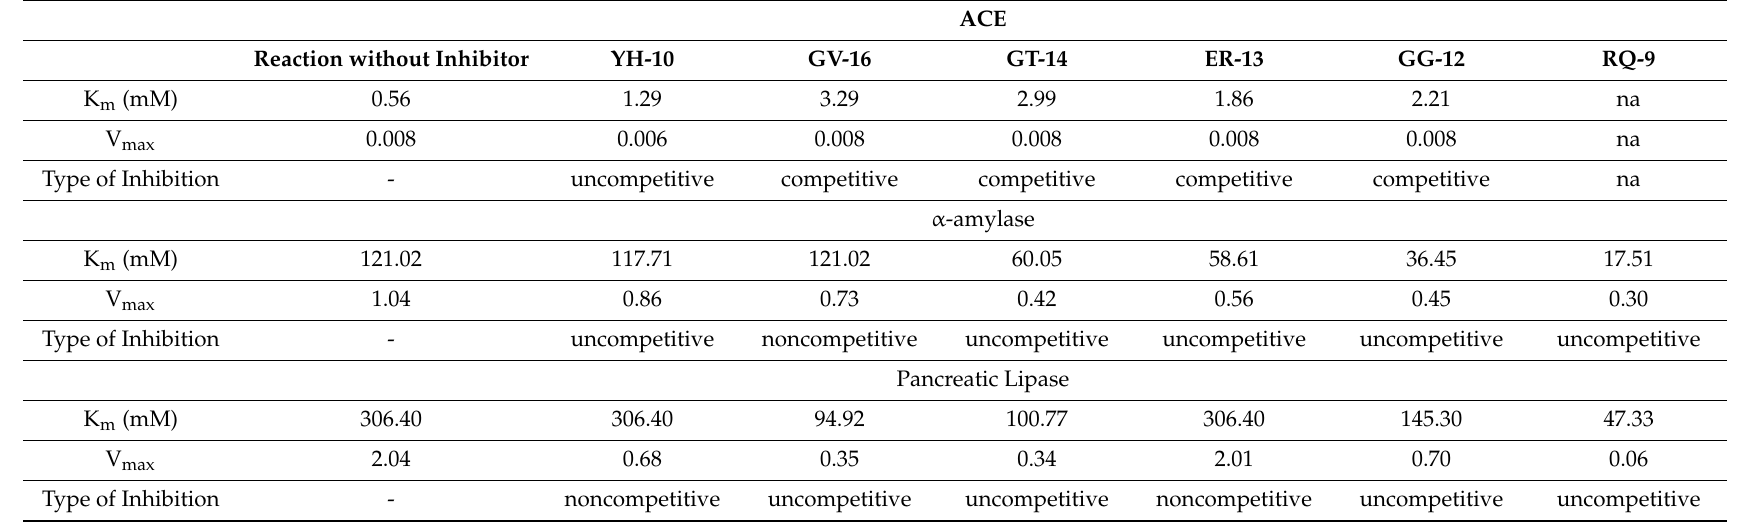
Table 4. Kinetic parameters of enzymes involved in metabolic syndrome pathogenesis with peptides as inhibitor and type of